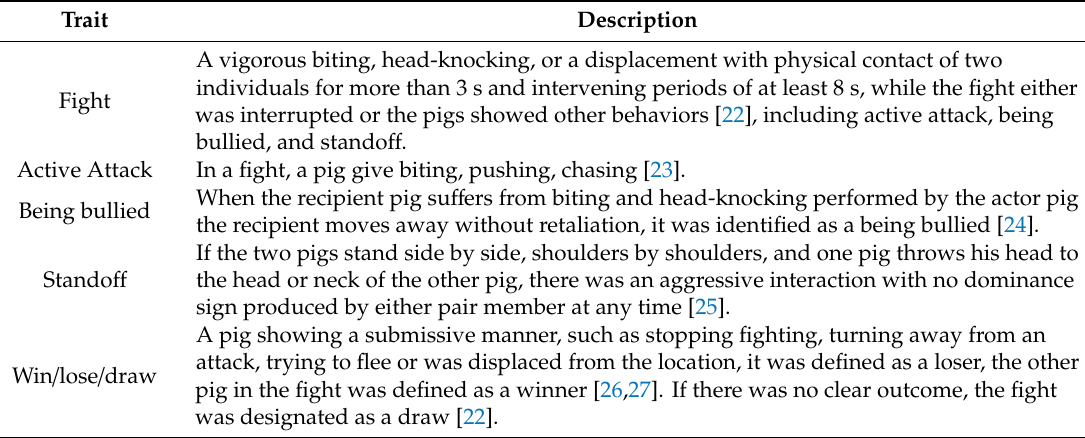
Table 1. Definitions of aggressive behavior traits used in the